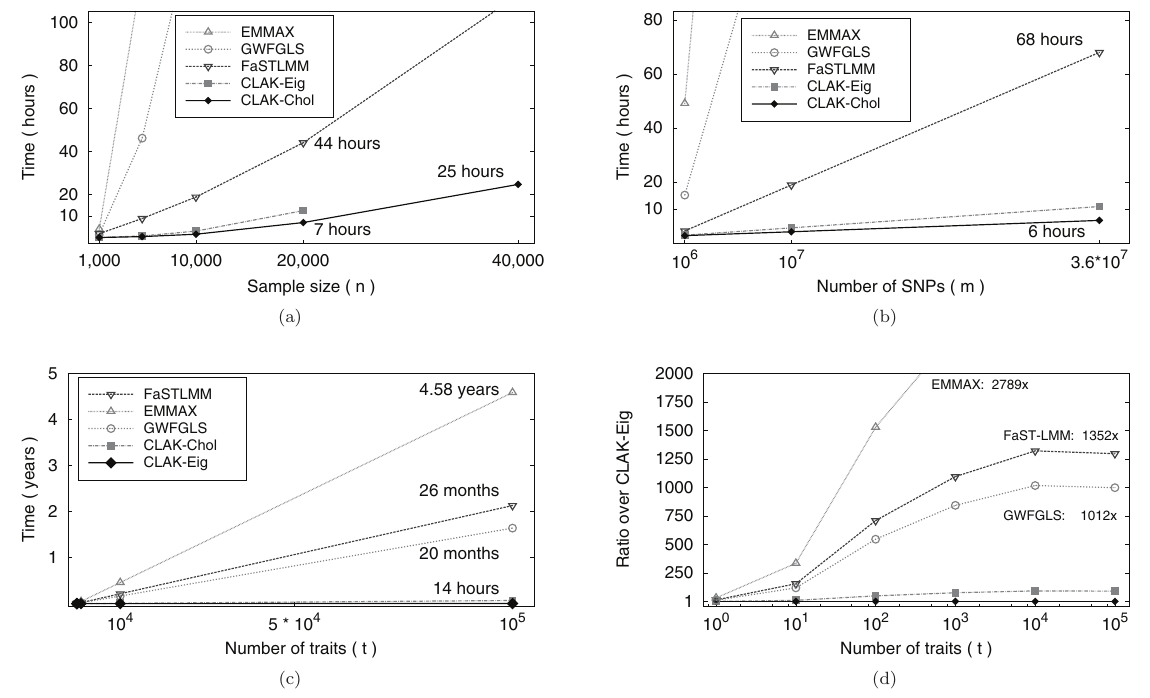
Figure 3. Timings comparison. Panels ( a ) and ( b ) include timings for EMMAX, GWFGLS, FaST-LMM, and our O mic ABEL software, for single trait analyses; ( c ) and ( d ) present a comparison of EMMAX, GWFGLS, FaST-LMM, and our O mic ABEL software, in the case of multiple traits. In ( a ), the number of SNPs is fixed to m = 10 7 and the sample size n ranges from 1,000 to 40,000. In panel ( b ), the sample size is fixed to n = 10,000 and the number of SNPs m ranges between 10 6 and 3.6 × 10 7 . In ( c ) and ( d ), n = 1,000, m = 10 6 and t ranges from 1 to